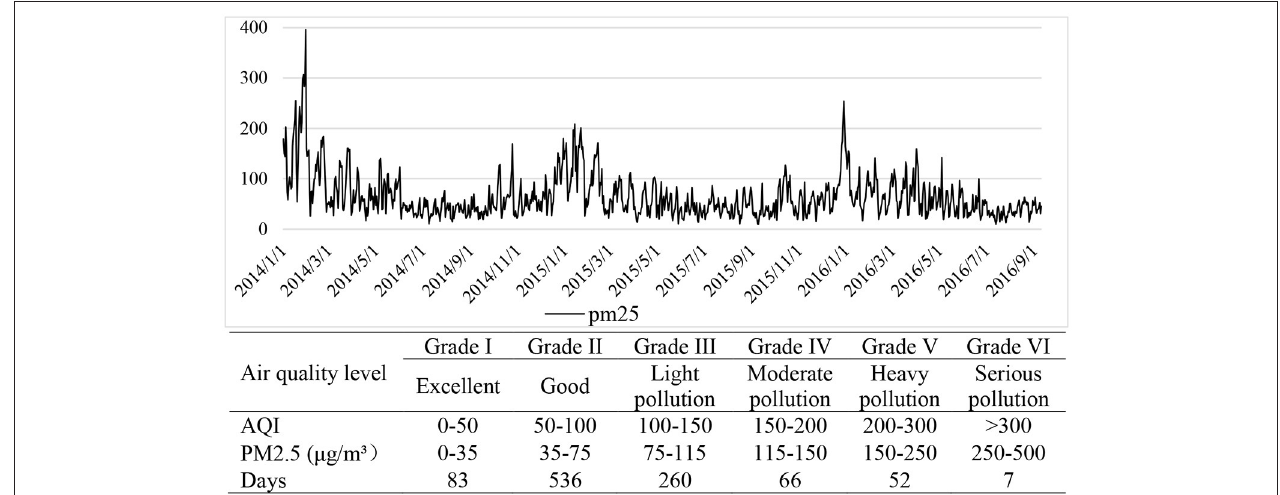
FIGURE 3 | The air quality of city C during the sample